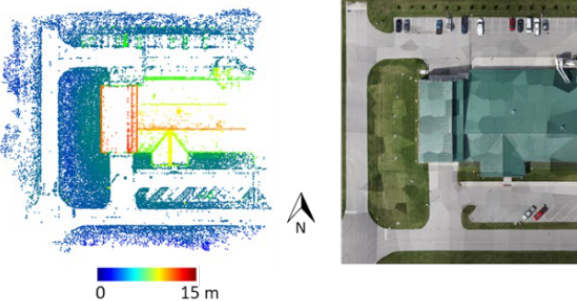
Figure 4. Generated sparse point cloud (colored by height) with 30,000 points and corresponding orthophoto for A-1